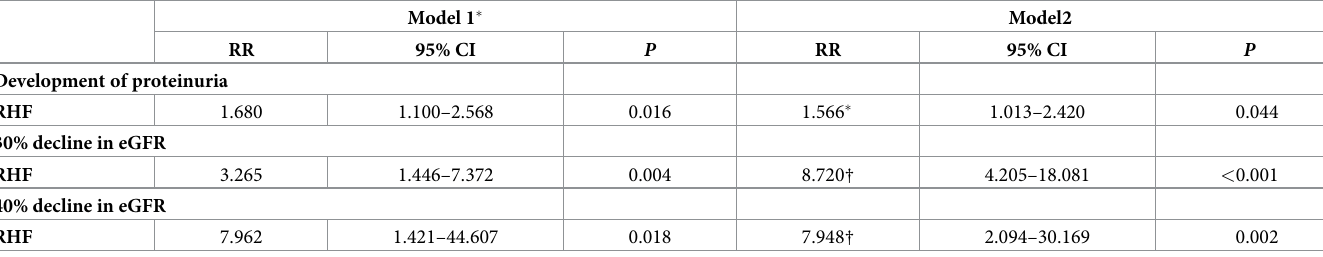
Table 2. Risks of renal hyperfiltration (RHF) for the development of proteinuria and decline of eGFR. Model 1